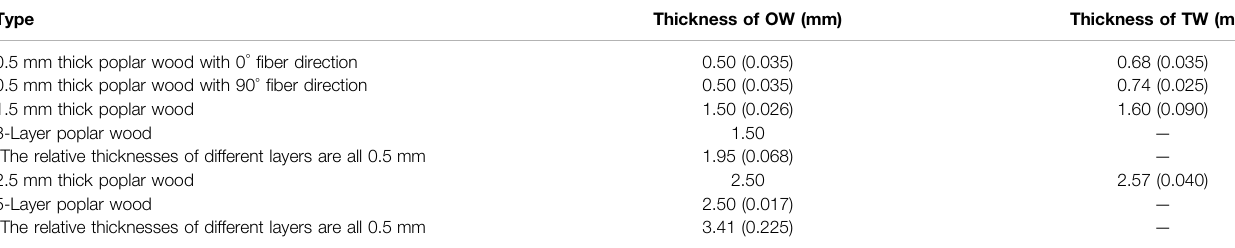
TABLE 2 | Thickness record of each sample before and after treatment. Type